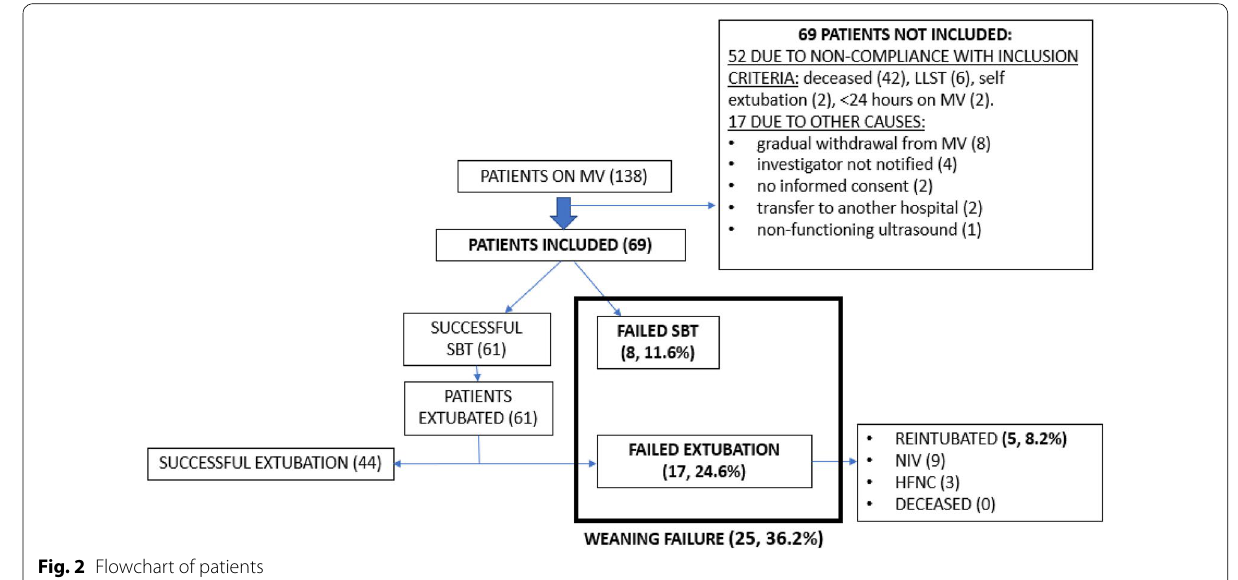
Fig. 2 Flowchart of patients